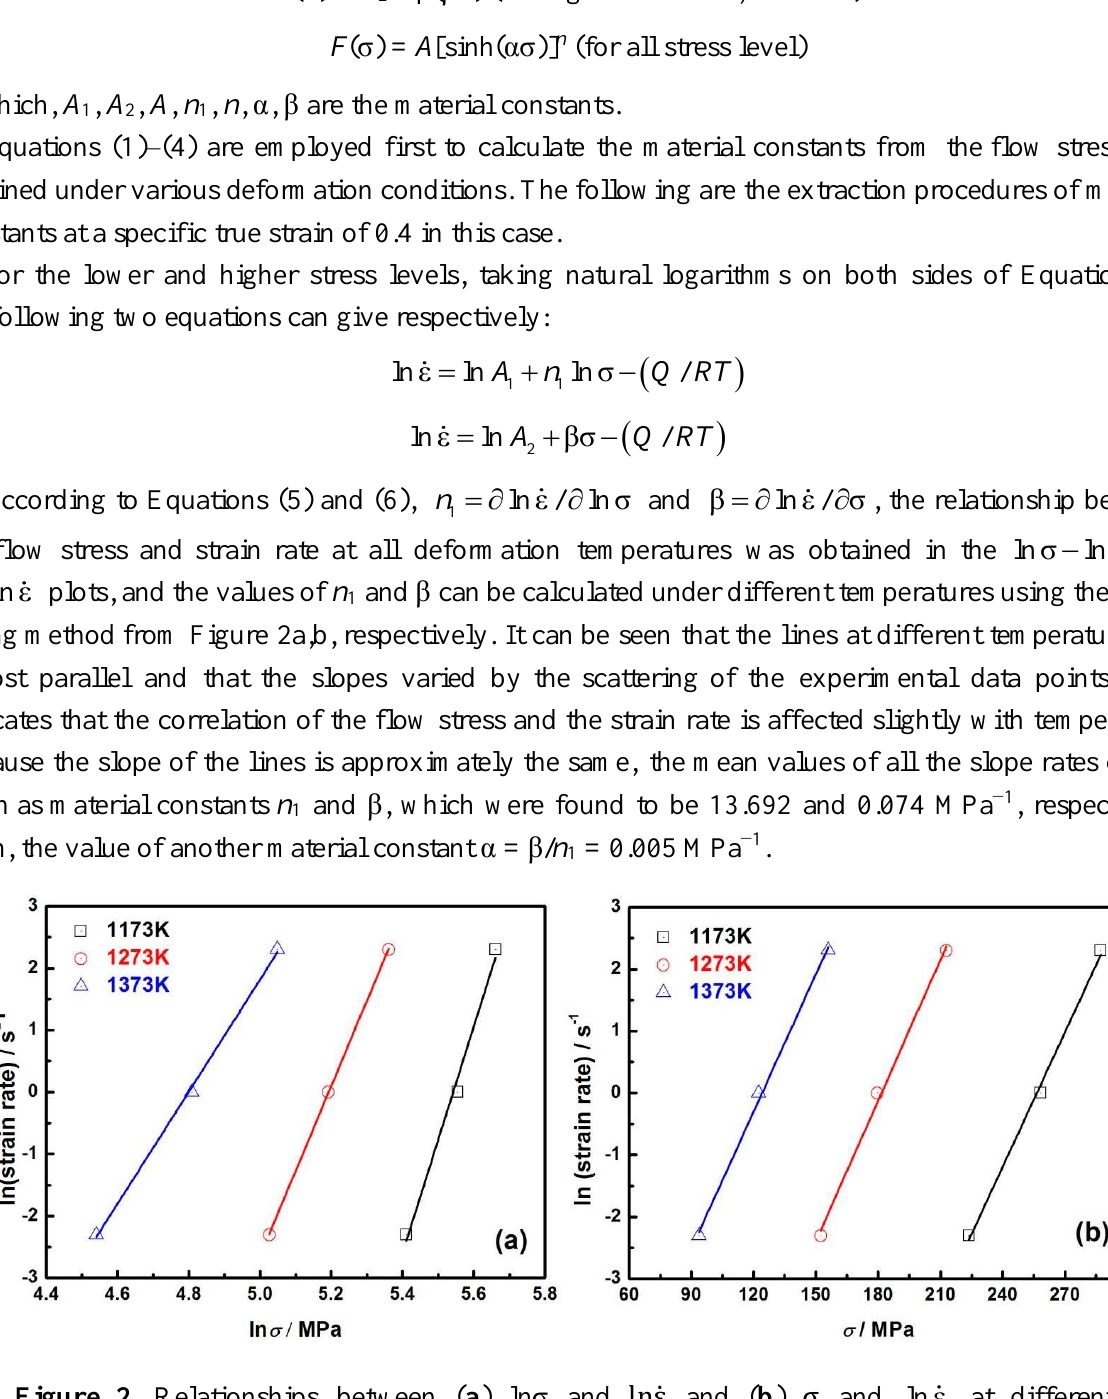
Figure 2. Relationships between ( a ) lnσ and lnε̇ and ( b ) σ and ln ε at different deformation